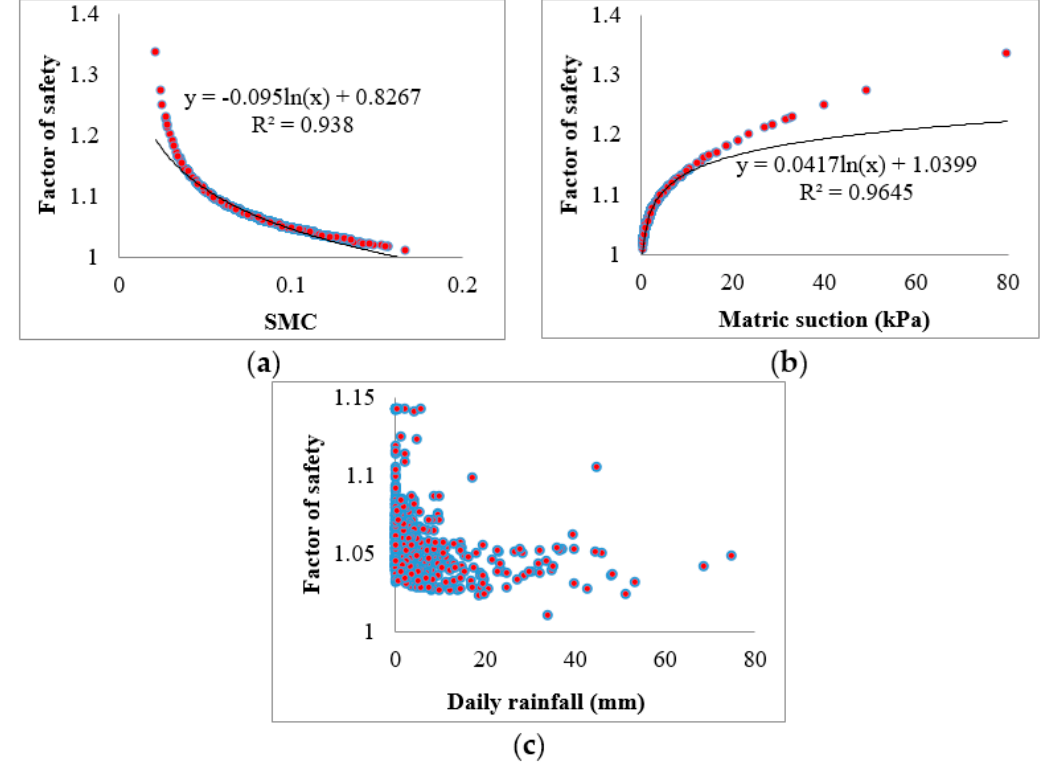
Figure 10. Correlation of slope stability and soil moisture content, matric suction and daily rainfall, plotting by the stability analysis. Modeled factor of safety versus ( a ) observed volumetric water content, ( b ) observed suction and ( c ) observed daily rainfall which indicates the water contents and suction thresholds models for early warning of the mass-remobilization in the Yindongzi landslide site in hollows of debris flows of the Wenchuan earthquake region.